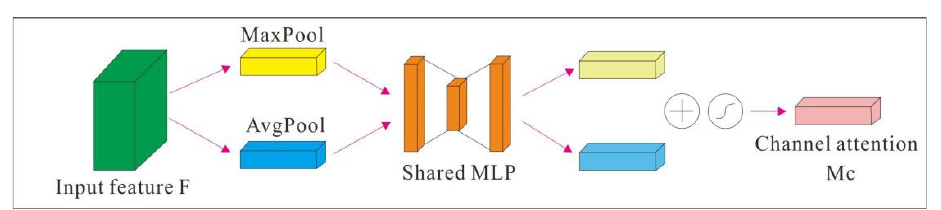
Figure 10. Channel attention module.